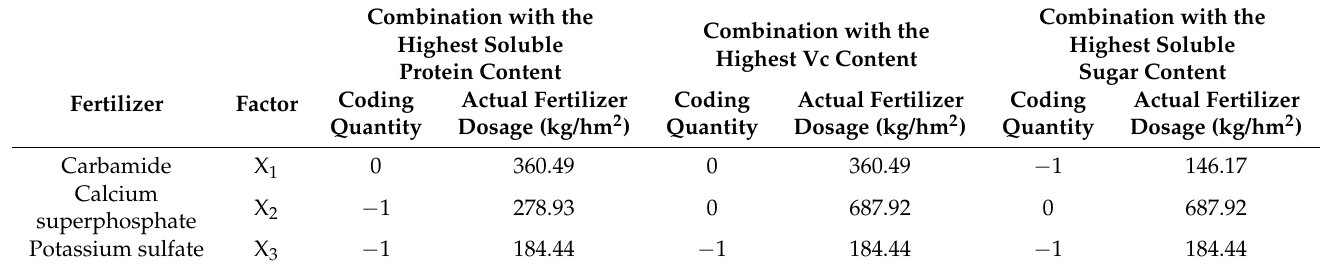
Table 5. Analysis of fertilizer levels leading to the best quality in